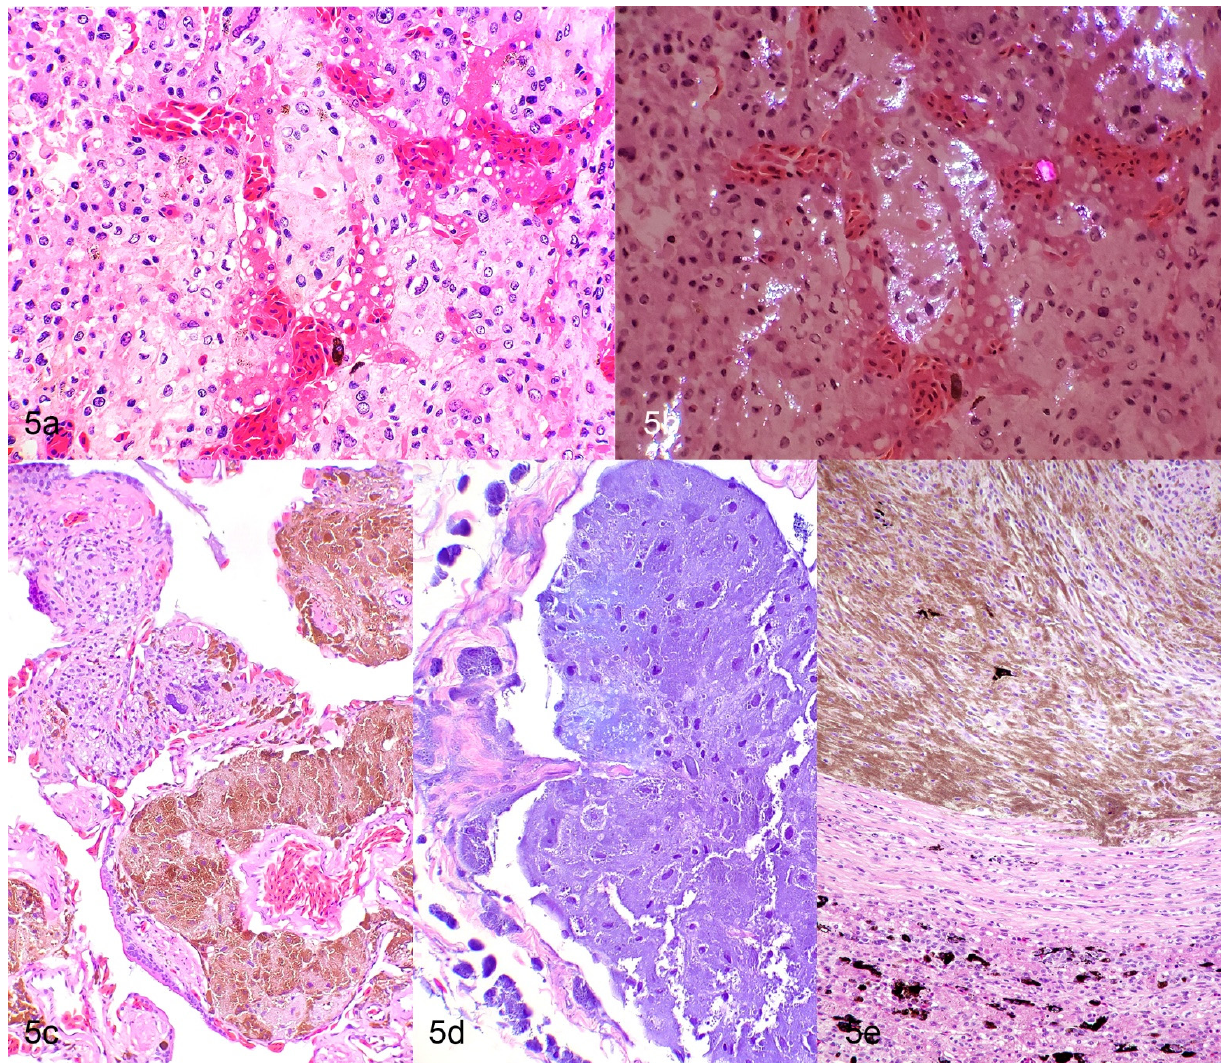
Figure 5. Histologic features of metastatic chromatophoromas in reptiles. ( a , b ) Hepatic metastasis of an iridophoroma in a veiled chameleon ( Chamaeleo calyptratus ). H&E ( a ) and H&E with polarized light ( b ). ( c , d ) Pulmonary metastasis of a melanoma in a rosy boa ( Charina trivirgata ). H&E ( c ) and H&E with bleach ( d ). ( e ) Hepatic metastasis of a melanoma in a chameleon ( Chamaeleo sp.). H&E.